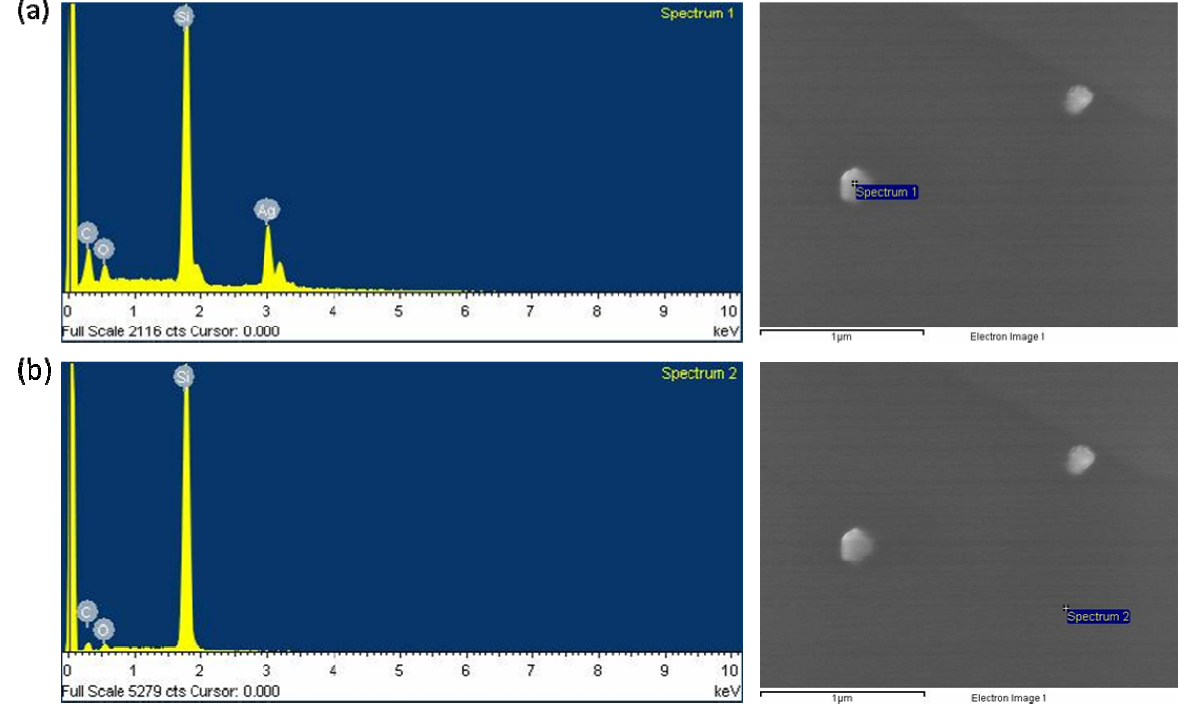
Figure 7. Energy dispersive X-ray spectrum and images of the Ag/PAAc nanogel;